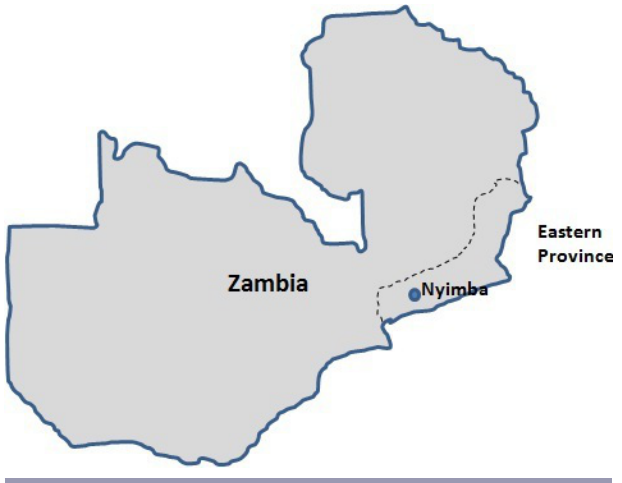
Fig. 1 . Location of Zambia’s Eastern Province, which borders on Mozambique to the south. Most of our fieldwork took place in the Nyimba district (bottom